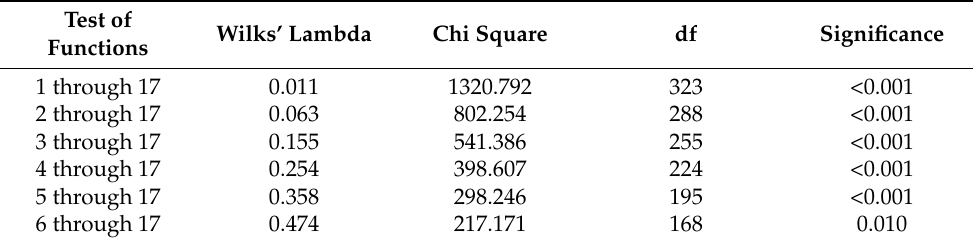
Table 6. Canonical Discriminant analysis efficiency parameters to determine the significance of each